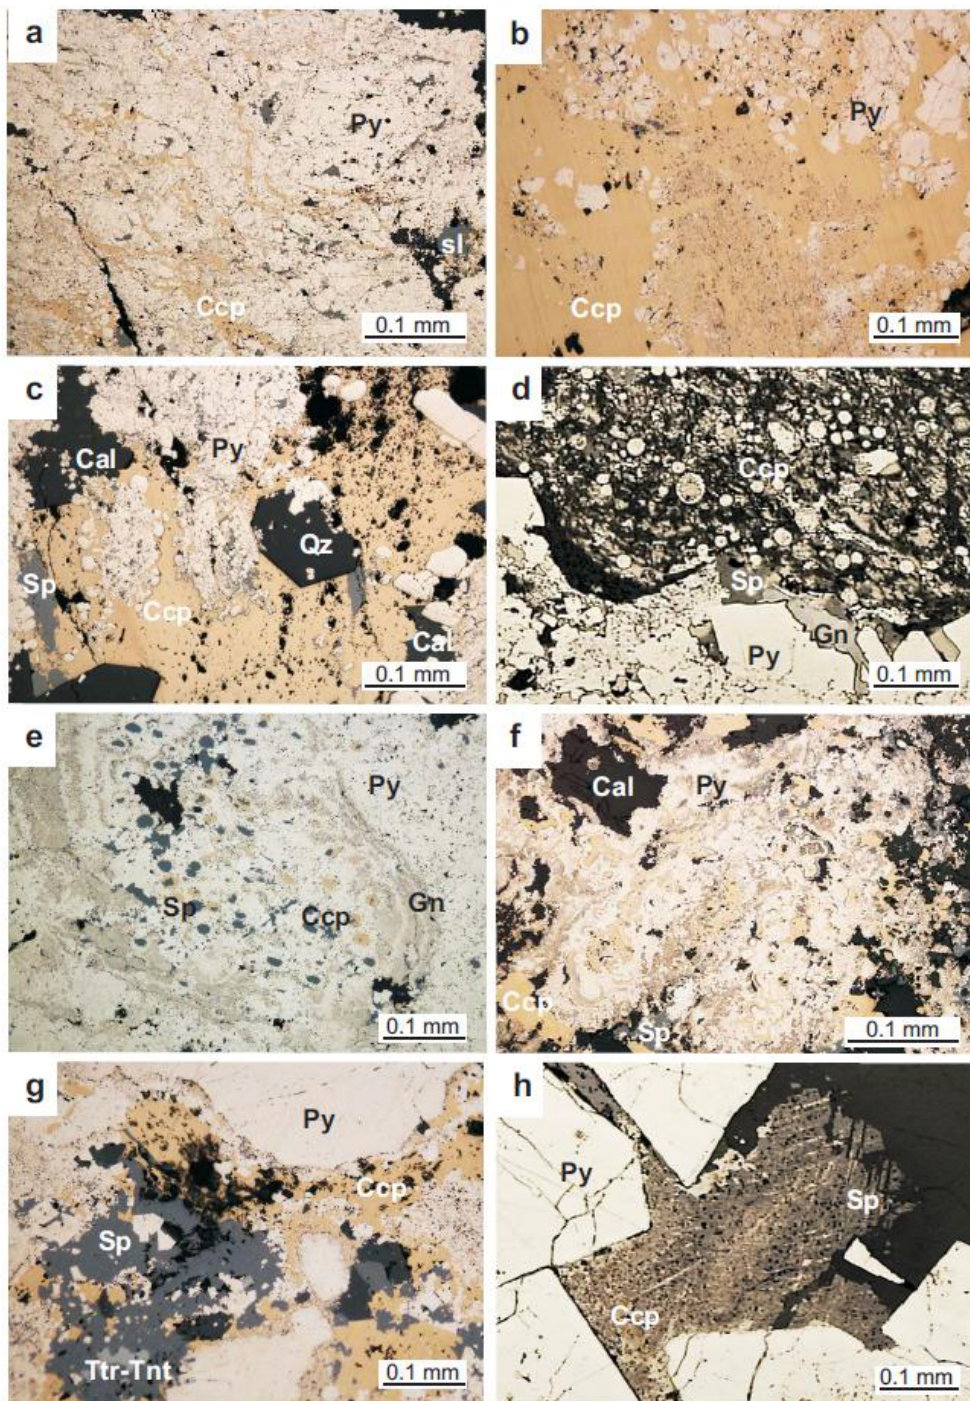
Figure 7. Optical microscope images of cupriferous mineralizations from several massive sulfide deposits of the IPB. ( a ) and ( b ) interstitial chalcopyrite (Cpp) replacing inequigranular pyrite (Py) aggregates; ( c ) replacement texture of chalcopyrite on pyrite, associated with quartz (Qz) and calcite (Cal); ( d ) pyrite framboids partially replaced by chalcopyrite; ( e , f ) framboidal ( e ) and colloform ( f ) primary pyrite textures replaced by chalcopyrite, sphalerite (Sp) and galena (Gn), associated with late carbonates filling open spaces; ( g ) late chalcopyrite replaced sphalerite that filled interstices in partially corroded pyrite crystals; ( h ) chalcopyrite disease on interstitial coarse grained sphalerite. Frailes deposit ( a ), Aznalcóllar deposit ( b , d , h ) and Magdalena deposit ( c , e – g ).